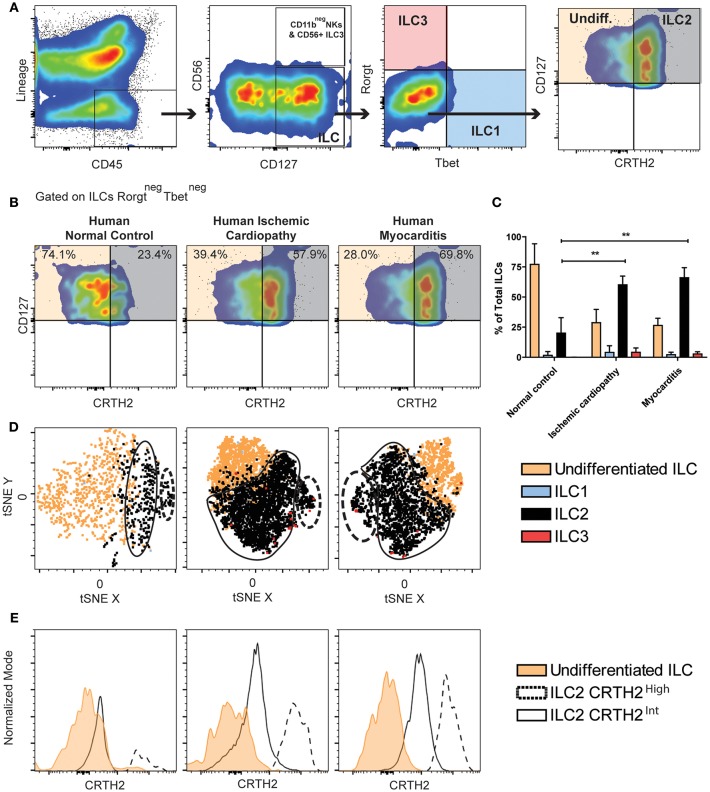
Majority of human ILCs are undifferentiated in healthy hearts, whereas ILC2s predominate in ischemic cardiomyopathy and myocarditis. (A) Human cardiac ILCs gating strategy, ILCs were defined as CD45+LineagenegCD127+, NK cells as CD56+NKp44+, non-cytotoxic ILC1s (blue) as Tbet+, ILC2s (gray) as CRTH2+GATA3int−high, ILC3s (transparent red) as Rorγt+IL-23R+. Undifferentiated ILCs (transparent orange) were defined as ILCs negative for all type-specific markers. (B) Representative flow cytometry plots showing median examples of the profile of undifferentiated ILCs and ILC2s gated in Rorγtneg Tbetneg ILCs. (C) Frequency of ILC subsets in healthy human hearts, ischemic cardiomyopathy and myocarditis. (D) tSNE clustering analyses of ILCs immunophenotypes. (E) Comparison of CRTH2 expression in two distinctive ILC2s population in normal hearts, ischemic cardiomyopathy and myocarditis. Data show n = 5 for ischemic cardiomyopathy, n = 5 for myocarditis and n = 4 for controls. tSNE plots are concatenates of all the samples for group. Bar graphs shows Mean and SD. Statistics were calculated using Dunnett's test. **P < 0.01.